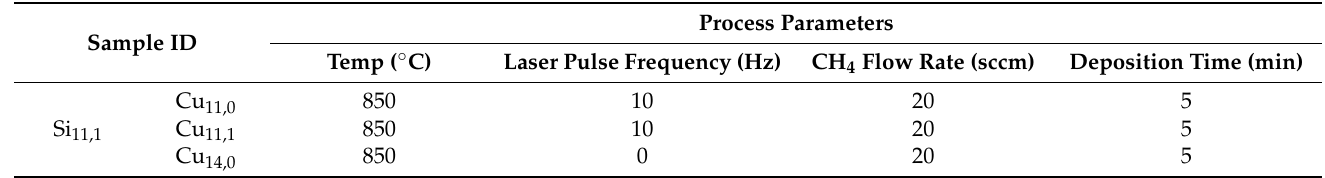
Table 2. Effect of laser energy on PyC